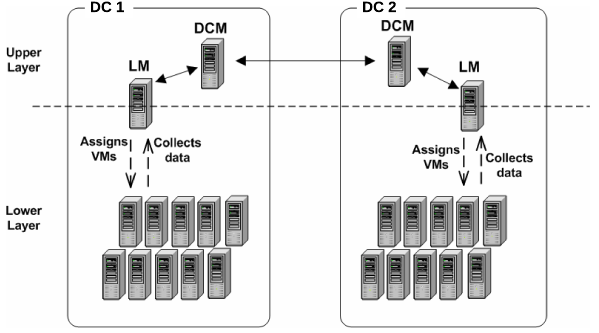
Figure 1. The EcoMultiCloud approach: the hierarchical two-level architecture in the case of two interconnected data centers. DCM, data center manager; LM, local